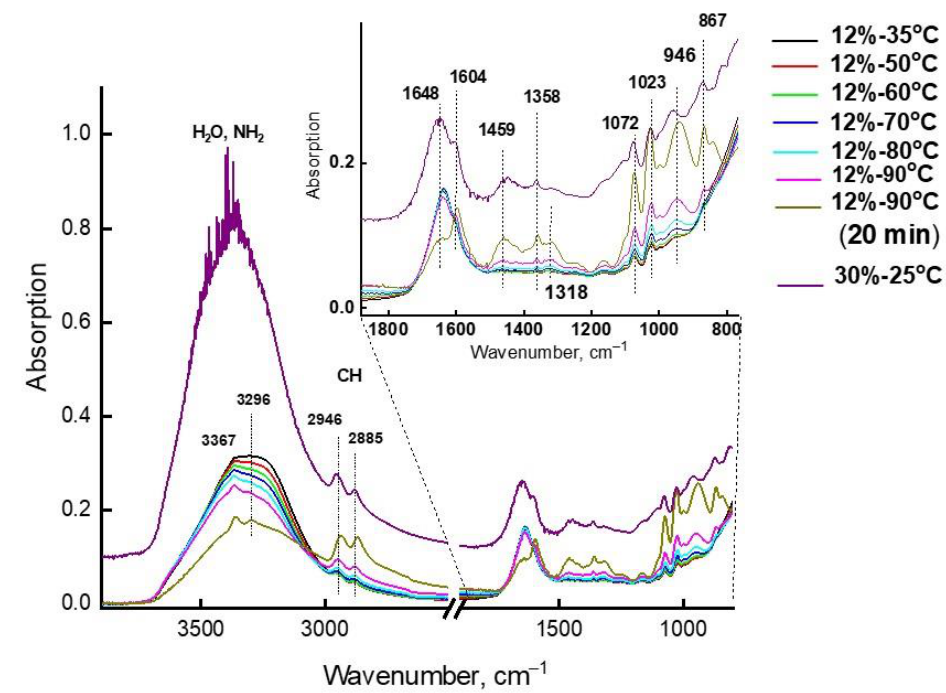
Figure 7. High-temperature IR absorption spectra of 12% aqueous MEA solutions: 1 – 35 °C, 2 – 50 °C,